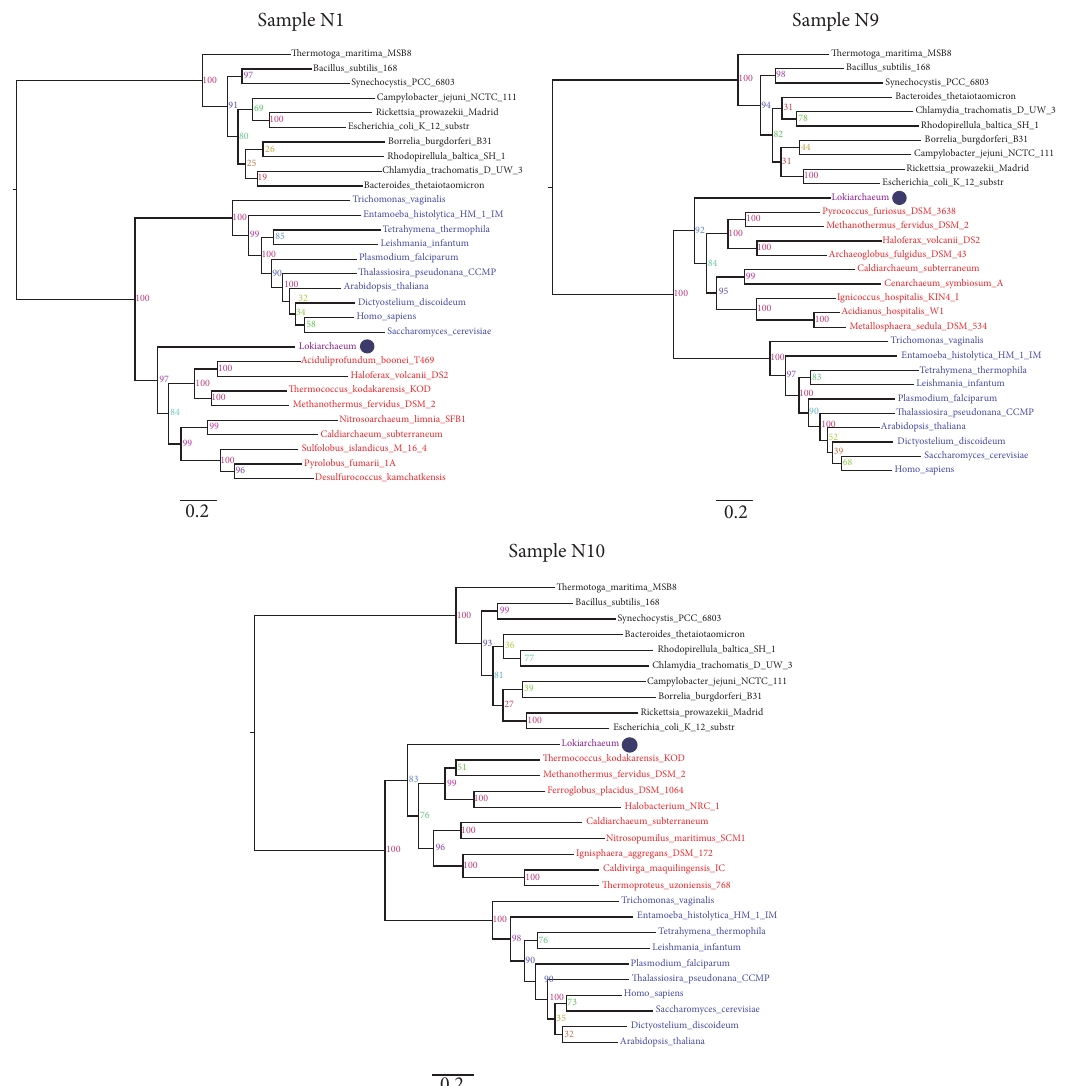
Figure 4: ML tree with revised datasets N1, N9, and N10 (see also Figures S1, S9, and S10 in the Supplementary Material available online at http://dx.doi.org/10.1155/2016/1851865). PhyML (ver. 3.1) [51] was used for ML tree reconstruction using LG amino acid substitution model and four categories of evolutionary rates ( Γ 4). The tree search topology operations were based on the BEST option (both NNI and SPR algorithms). Bacterial, eukaryal, Lokiarchaeum (Loki 1), and the rest of the archaeal species are indicated in black, blue, purple, and red, respectively. The purple circle identifies the position of Loki 1. The scale bar represents the average number of substitutions per site. Values at nodes represent support calculated by nonparametric bootstrap (out of